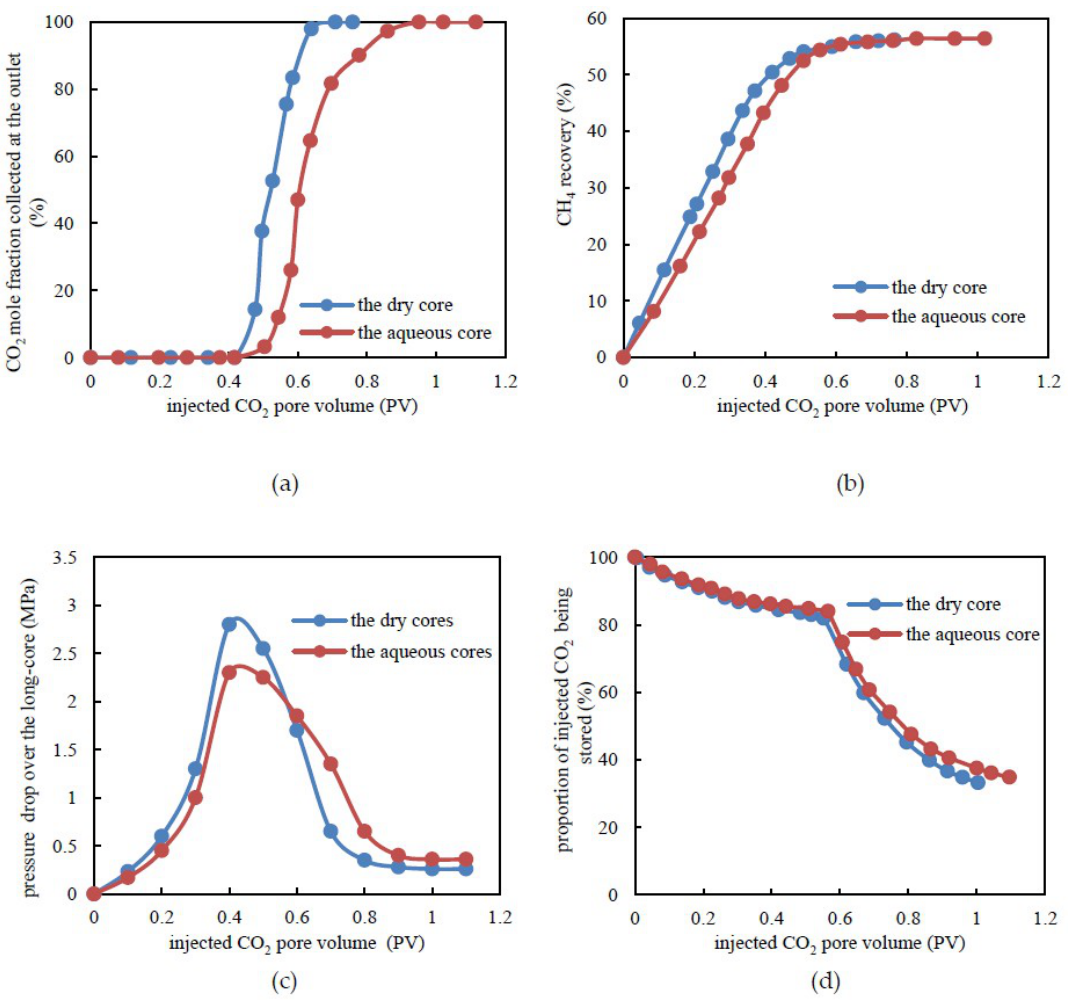
Figure 5. Experimental results under tight dry and aqueous cores. ( a ) CO 2 mole fraction at the outlet versus injected CO 2 pore volume. ( b ) CH 4 recovery by CO 2 flooding. ( c ) Pressure drop over tight long-core versus the pore volume during CO 2 flooding. ( d ) The proportion of injected CO 2 being stored versus an injected CO 2 pore volume.